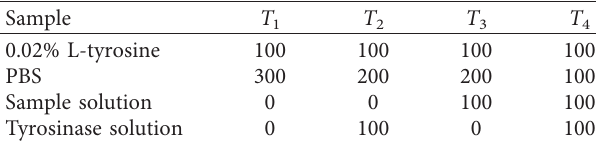
Table 3: Composition of reaction liquid (company: μ L).